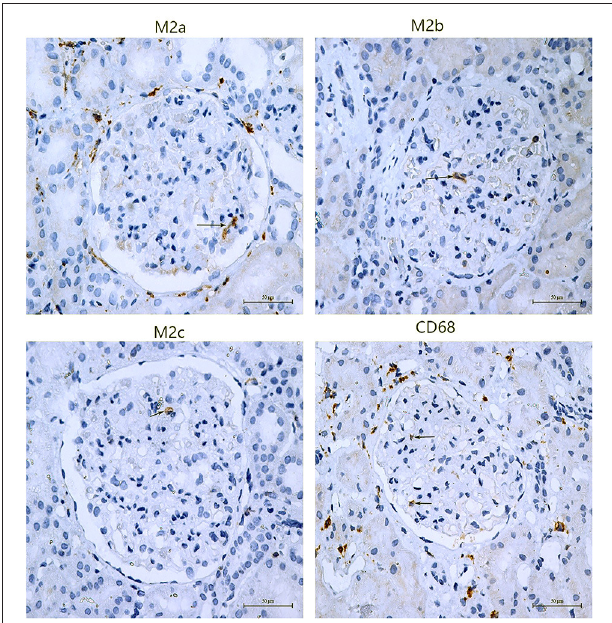
FIGURE 1 | Subpopulations of M2 macrophage in glomeruli of PMN patients. M2a macrophages were positive for CD206 by immunochemistry, M2b macrophages were positive for CD86, and M2c macrophages were positive for CD163. The arrows point to positive cells.